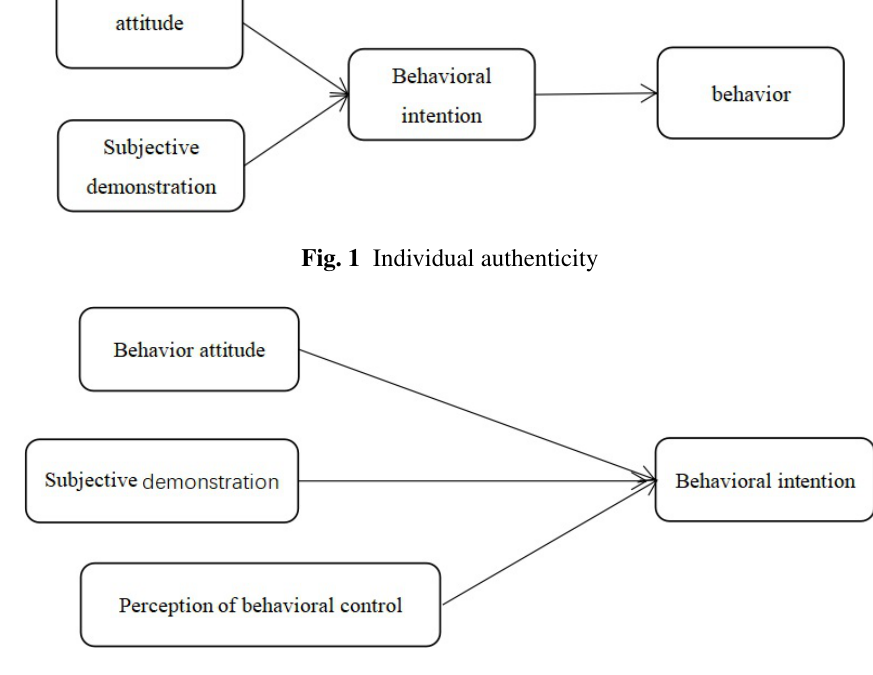
Fig. 2 Behavioural theory